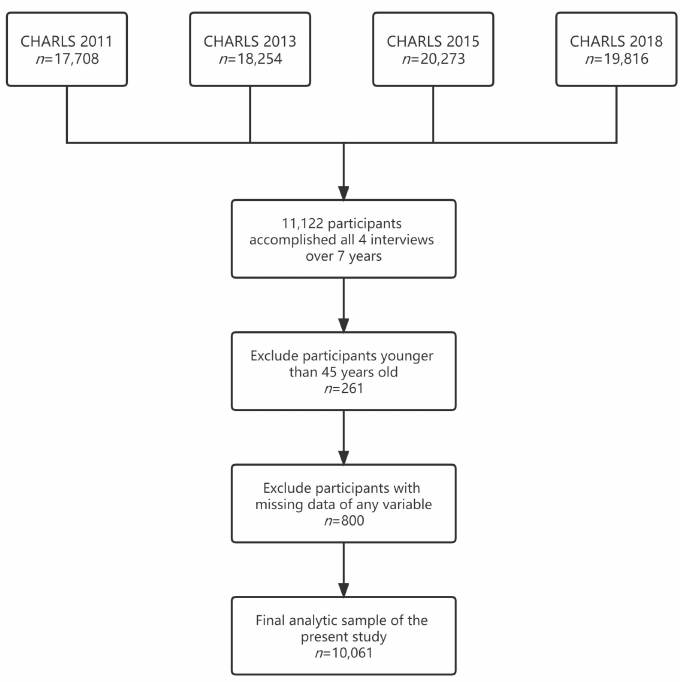
Figure 1. Sample screening of the present